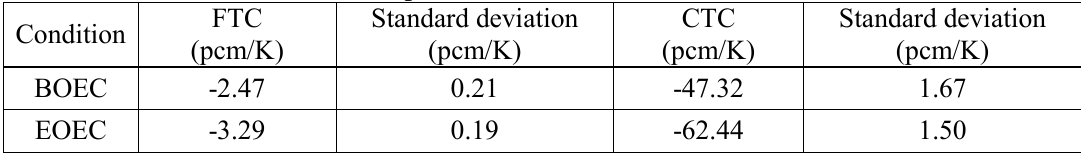
Table VI: The Fuel and Temperature Coefficients of the Two-batch ATOM